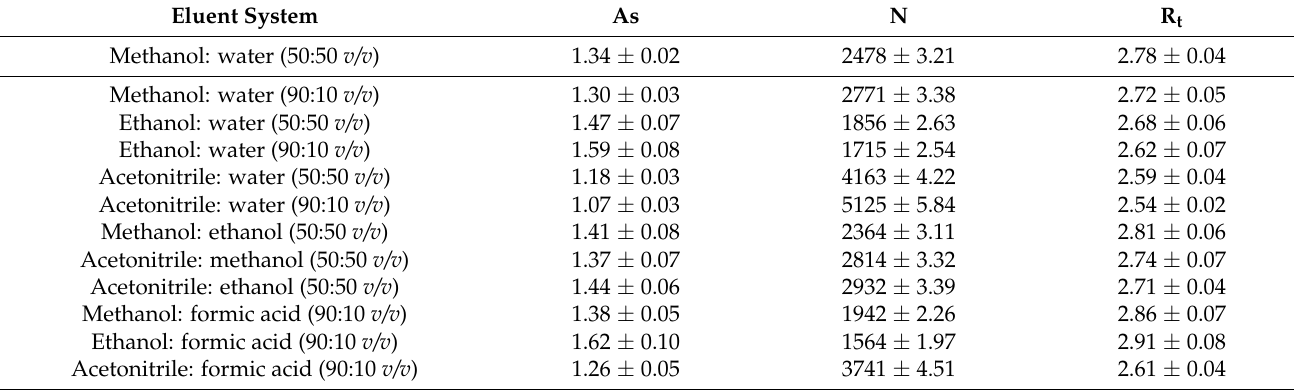
Table 1. Summary of the eluent systems and measured analytical responses for pterostilbene (PTT) (mean ± SD, n = 3).